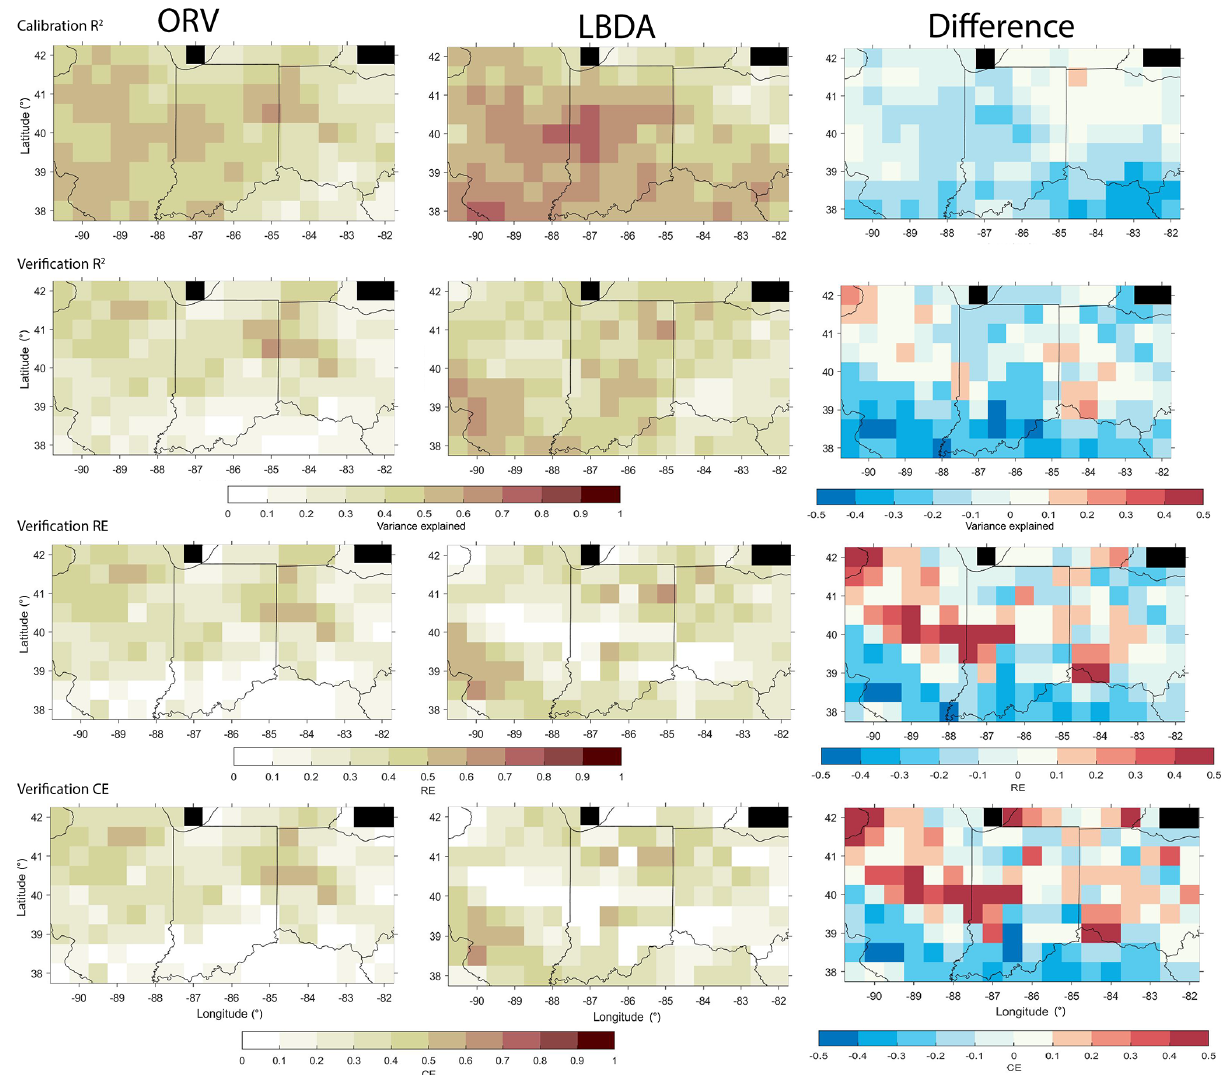
Figure 9. Comparison of the calibration (1901–1955) and validation (1956–2010) statistics between the ORV (left column) and LBDA (right column) reconstructions. Difference represents LBDA values subtracted from ORV. Black cells represent values over water and therefore no